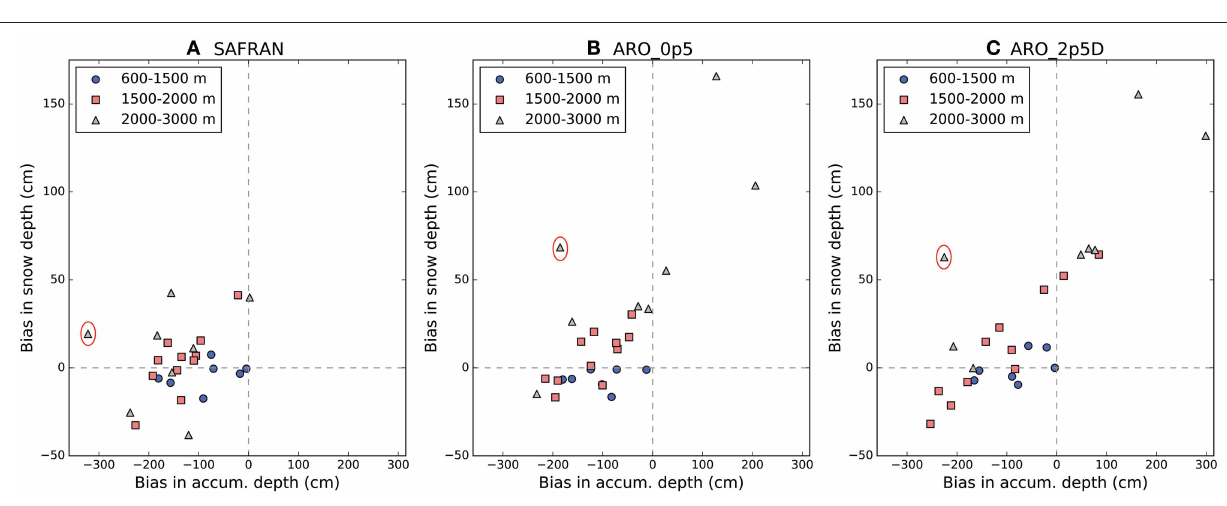
FIGURE 9 | Comparison of snow depth biases computed from October 1 to June 30 with biases in cumulative sum of positive daily snow depth change over the same period at 26 stations. Results of three Crocus simulations are considered: (A) SAFRAN , (B) ARO_0p5 , and (C) ARO_2p5D . On each graph, different symbols are used as a function of the stations elevation. The red circles highlight the results at a specific station which are discussed in the